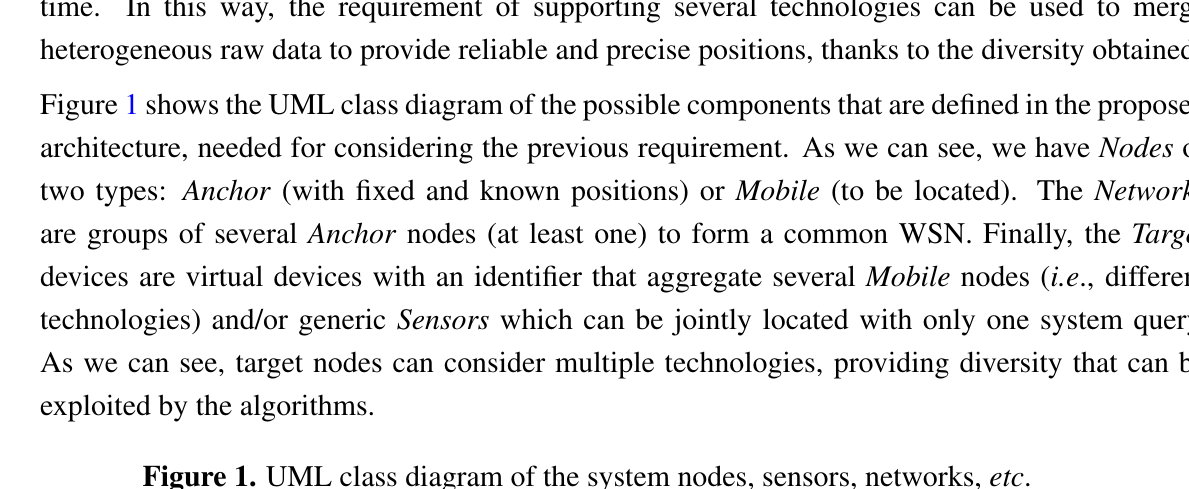
Figure 1. UML class diagram of the system nodes, sensors, networks, etc . Target *Network Node * SensorAnchor Mobile